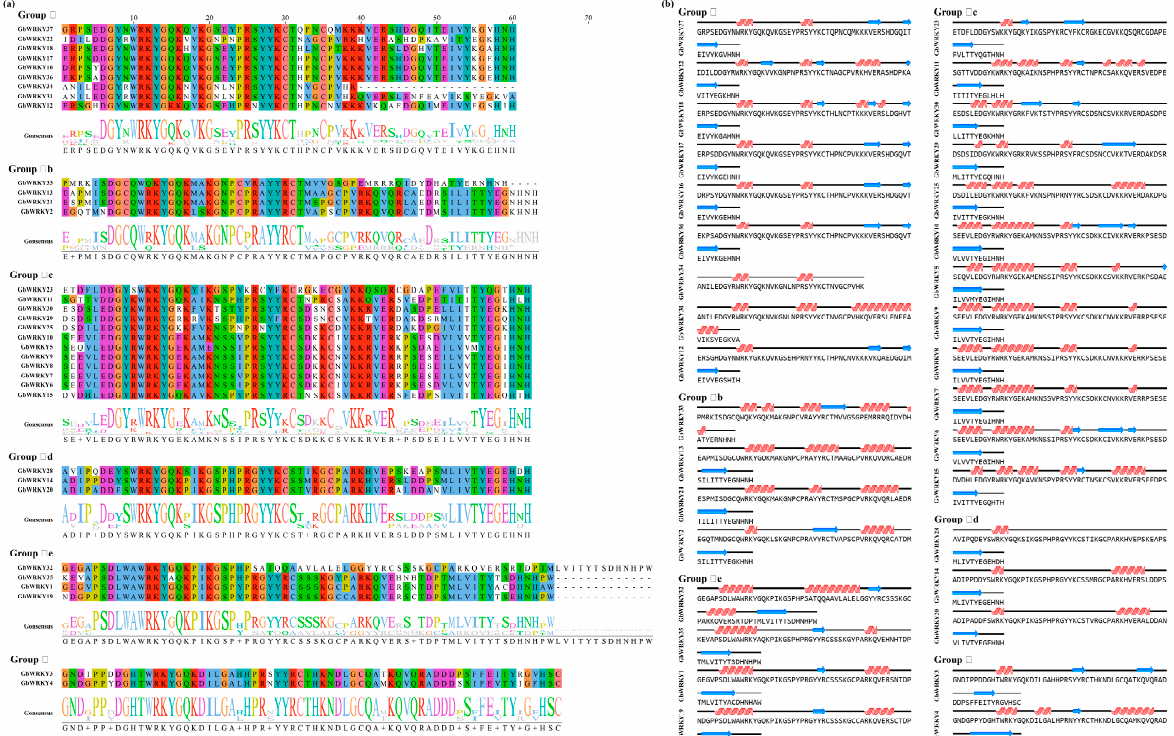
Figure 2. Multisequence alignment ( a ) and secondary structure ( b ) analysis of W − box in the GbWRKY proteins. ( a ) Identical amino acids are shown in same colors. ( b ) The secondary struc- tures were conducted by NovoPro Bioscience Inc, an online